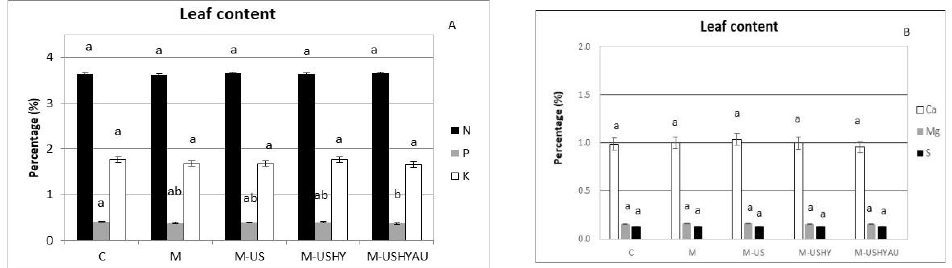
Figure 7. Leaf N, P, and K content (%) ( A ) and leaf Ca, Mg, and S content ( B ). Data are means ± standard error. Values followed by different letters are significantly different ( p ˂ 0.05). The values are the means of data from 12 plants for each replica.